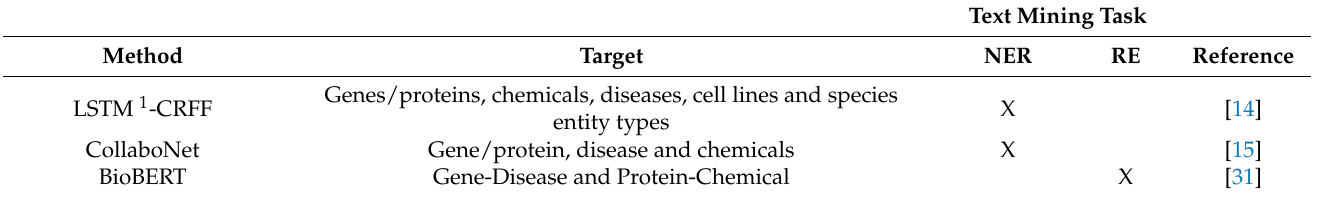
Table 1. Resume of the cited text mining